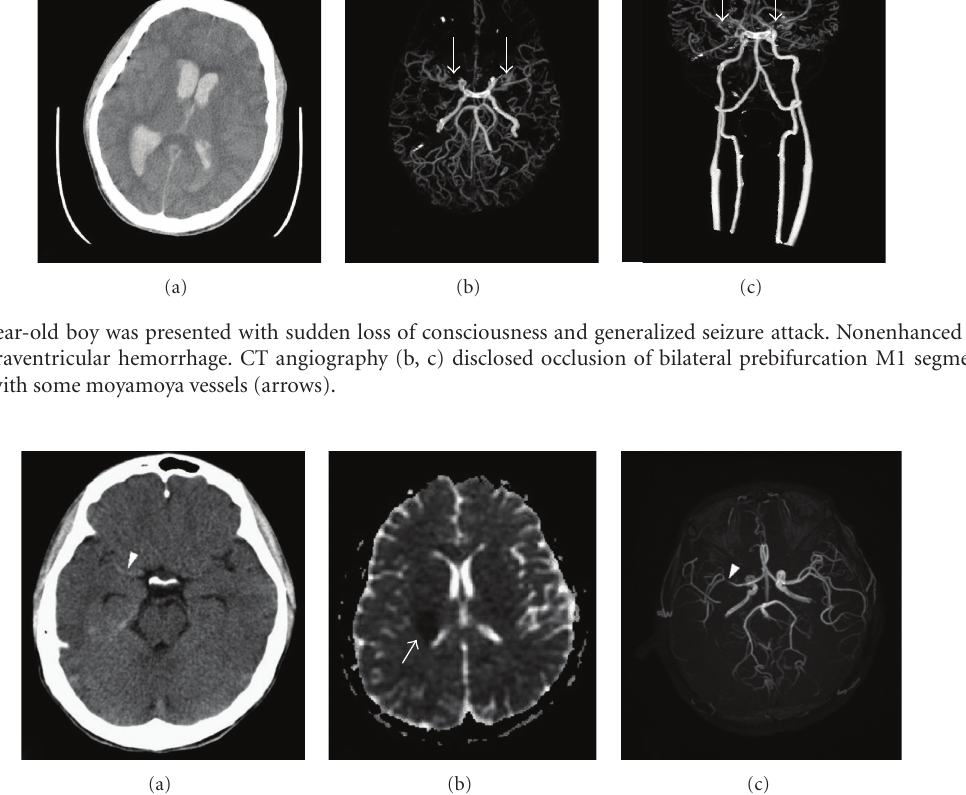
Figure 4: A 15-year-old boy suddenly experienced acute right-sided headache and dizziness followed by drowsy consciousnessand left-sided weakness after practicing backward somersaults. Nonenhanced CT image of the brain (a) showed increased attenuation at the M1 segment of the right MCA (white arrowhead). Apparent di ff usion map of the brain (b) delineated a 2.4-cm low-signal area in the posterior limb of the right internal capsule, consistent with a hyperacute infarct (arrow). Magnetic resonance angiography of the brain (c) showed focal stenosis of the right MCA with decreased flow and number of distal branches (white